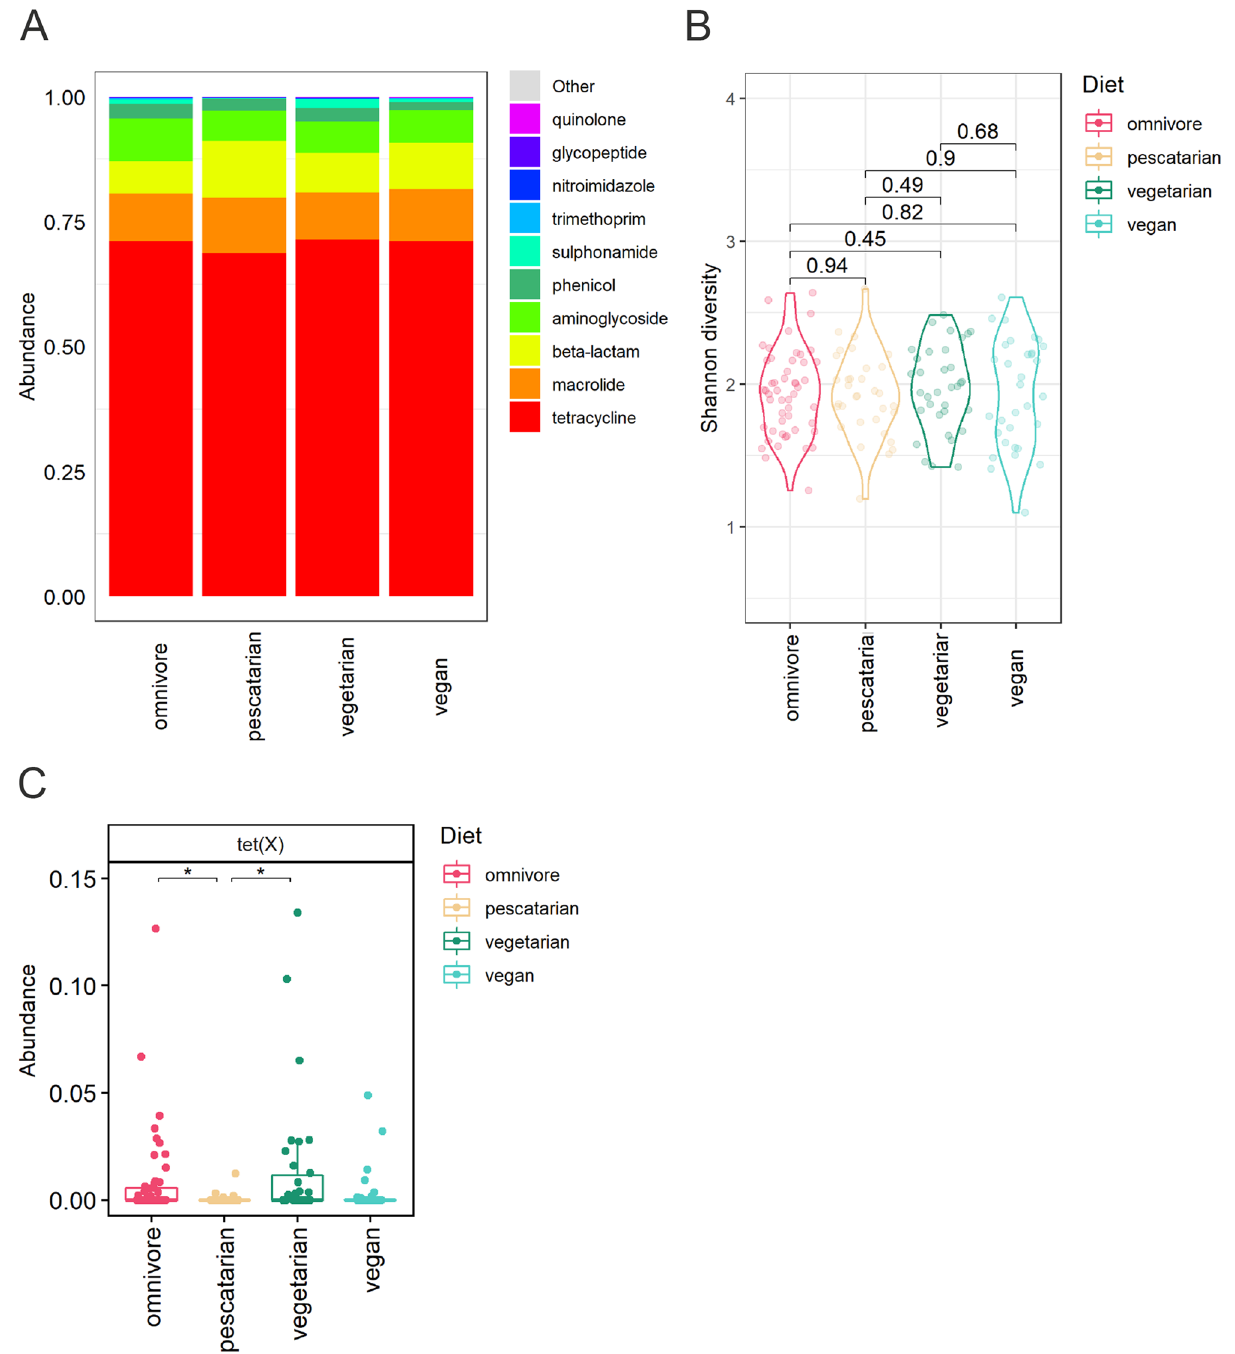
Figure 3. Association of dietary habits and the gut resistome composition through metagenomic shotgun sequencing. ( A ) Relative abundance of the 10 most abundant gene classes encoding antibiotic resistance, summarized per diet group. ( B ) Alpha diversity per diet group expressed by Shannon index. Differences in alpha diversity between diet groups were compared using Wilcoxon rank-sum tests. ( C ) Differential abundance analysis using ANCOM-BC plotted on relative abundance scale from 0.00 to 1.00. Adjusted p values below 0.05 are indicated by